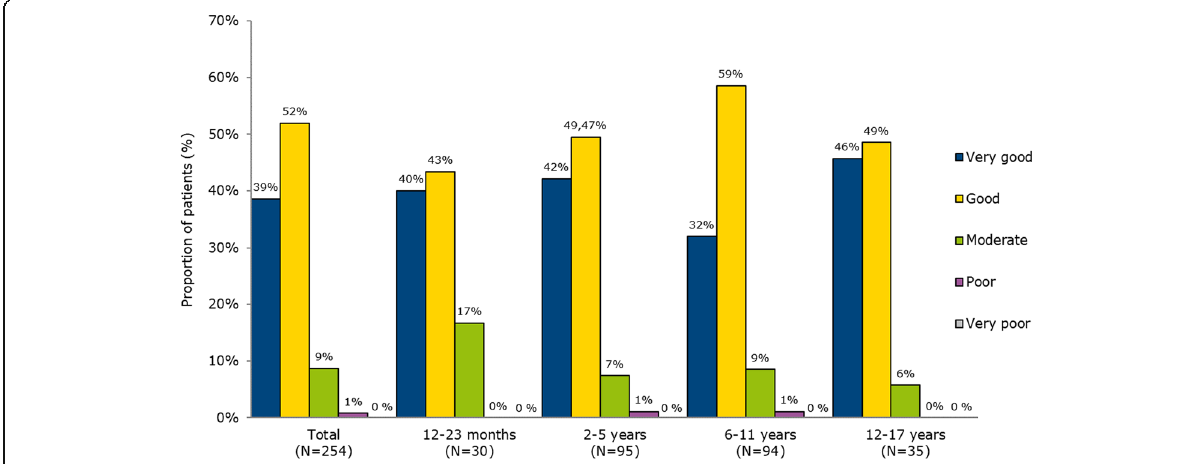
Fig. 8 Investigators assessment of effectiveness at end of study (monotherapy)